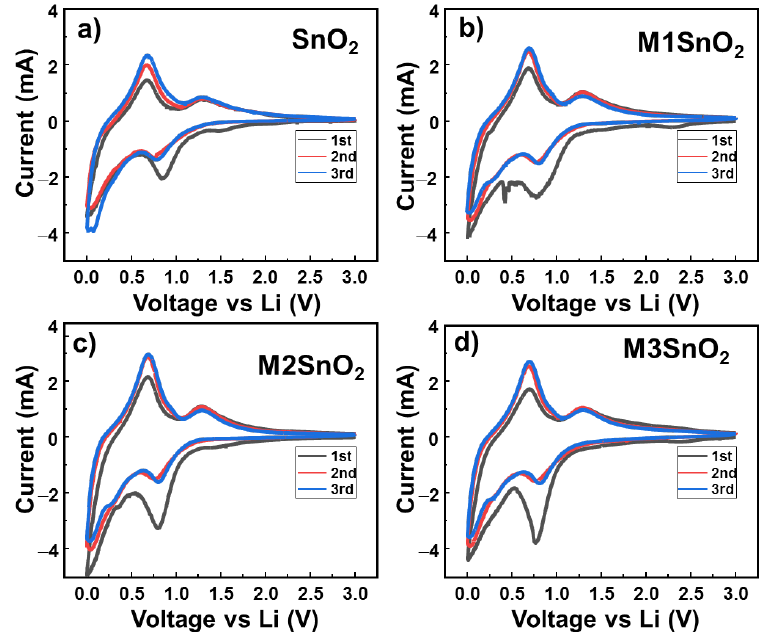
Figure 5. Cyclic voltammetry (CV) profiles of ( a ) SnO 2 NS and ( b – d ) M1 / M2 / M3SnO 2 anodes over three cycles.